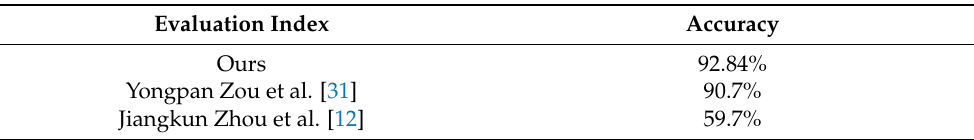
Table 16. Comparison of accuracy of fitness movement